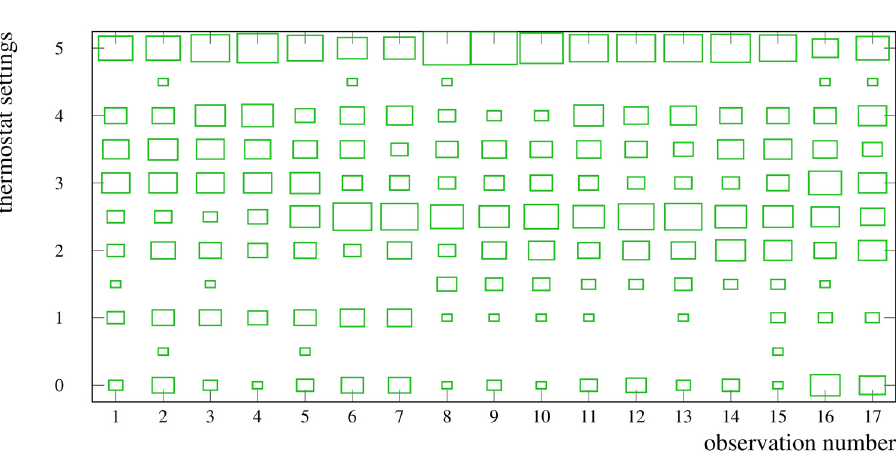
Figure 3 . The combined 2D distribution of thermostat readings in the test groups, G2 and